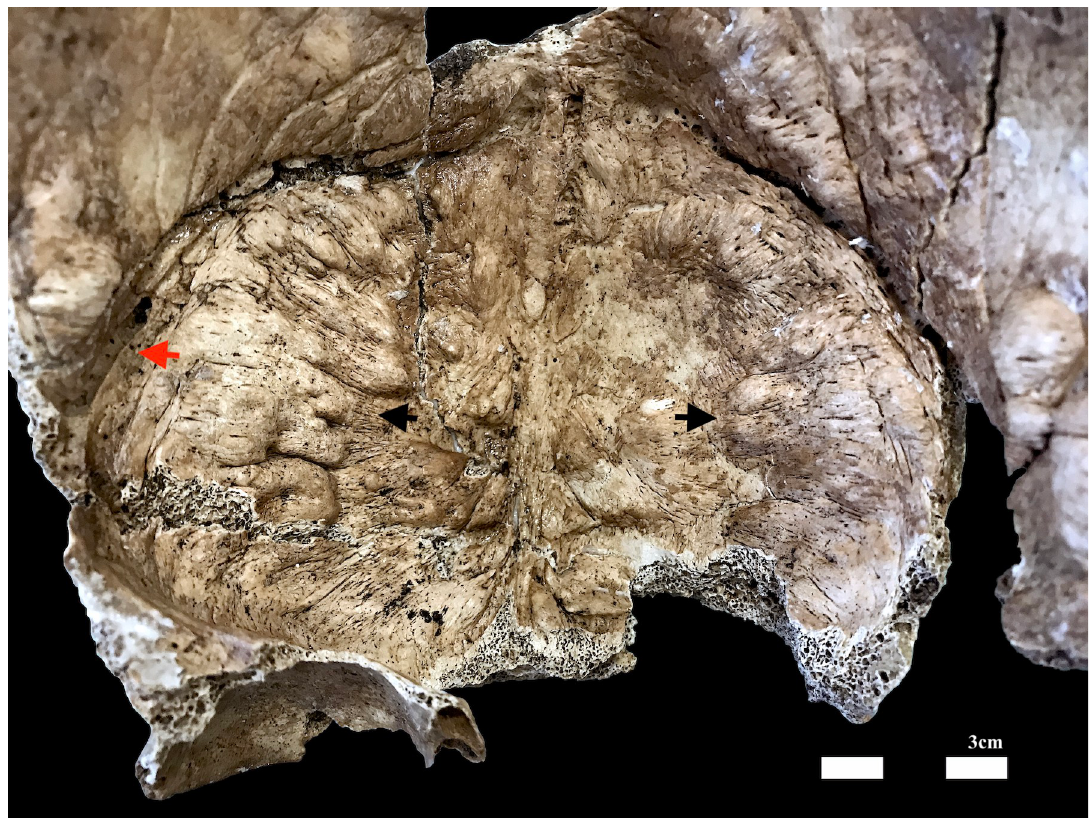
Fig 5. Detail of the bony overgrowth on the endocranial surface of the frontal and parietal bones (black arrows). On the left half of the frontal bone, very close to the coronal suture, it is possible to see the deep groove of the ascending branch of the middle meningeal artery (red